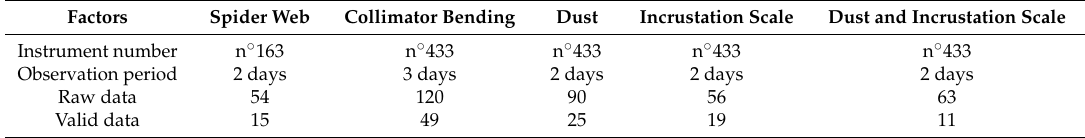
Table 1. Details of each experiment